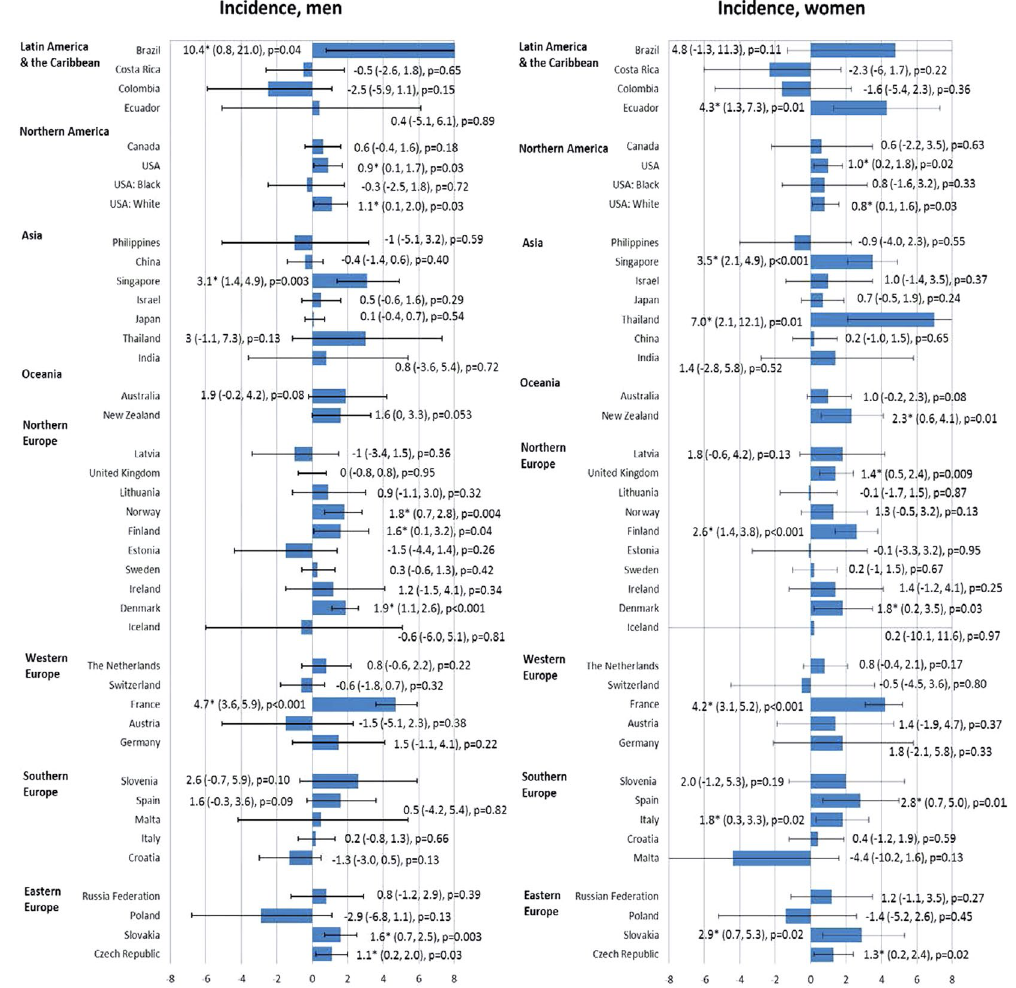
Figure 3. The Average Annual Percentage Change (AAPC) of pancreatic cancer incidence in men (left) and women (right)